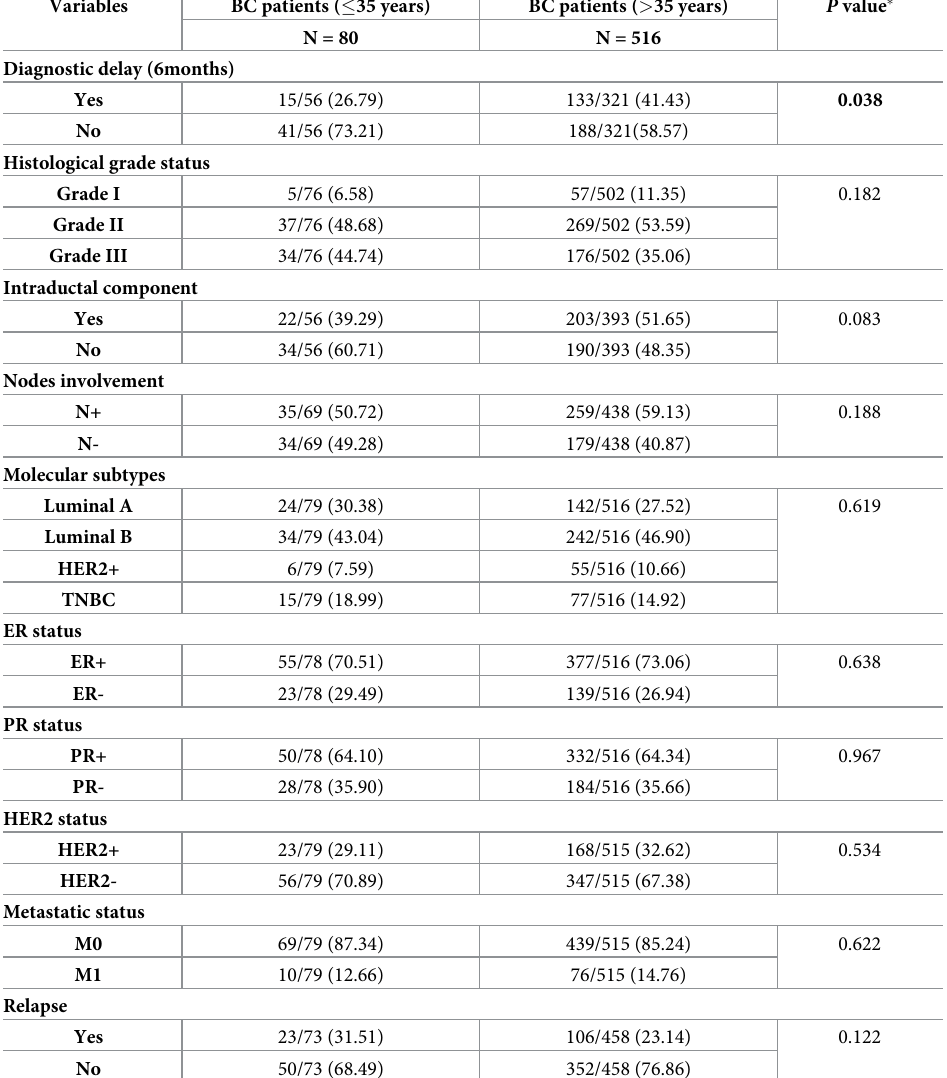
Table 2. Comparison of clinico-pathological features between 2 age groups (breast cancer patients � 35 years and > 35